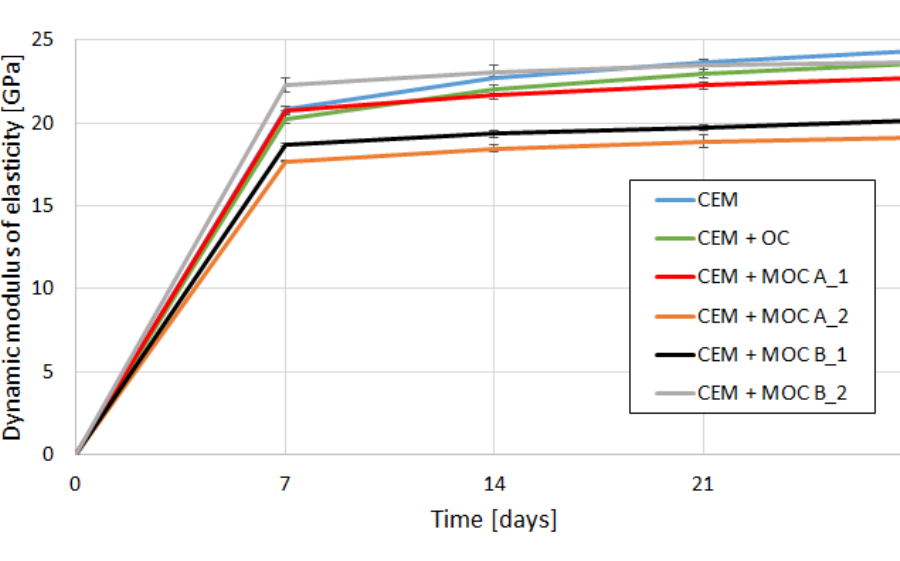
Figure 3. Development of dynamic modulus of